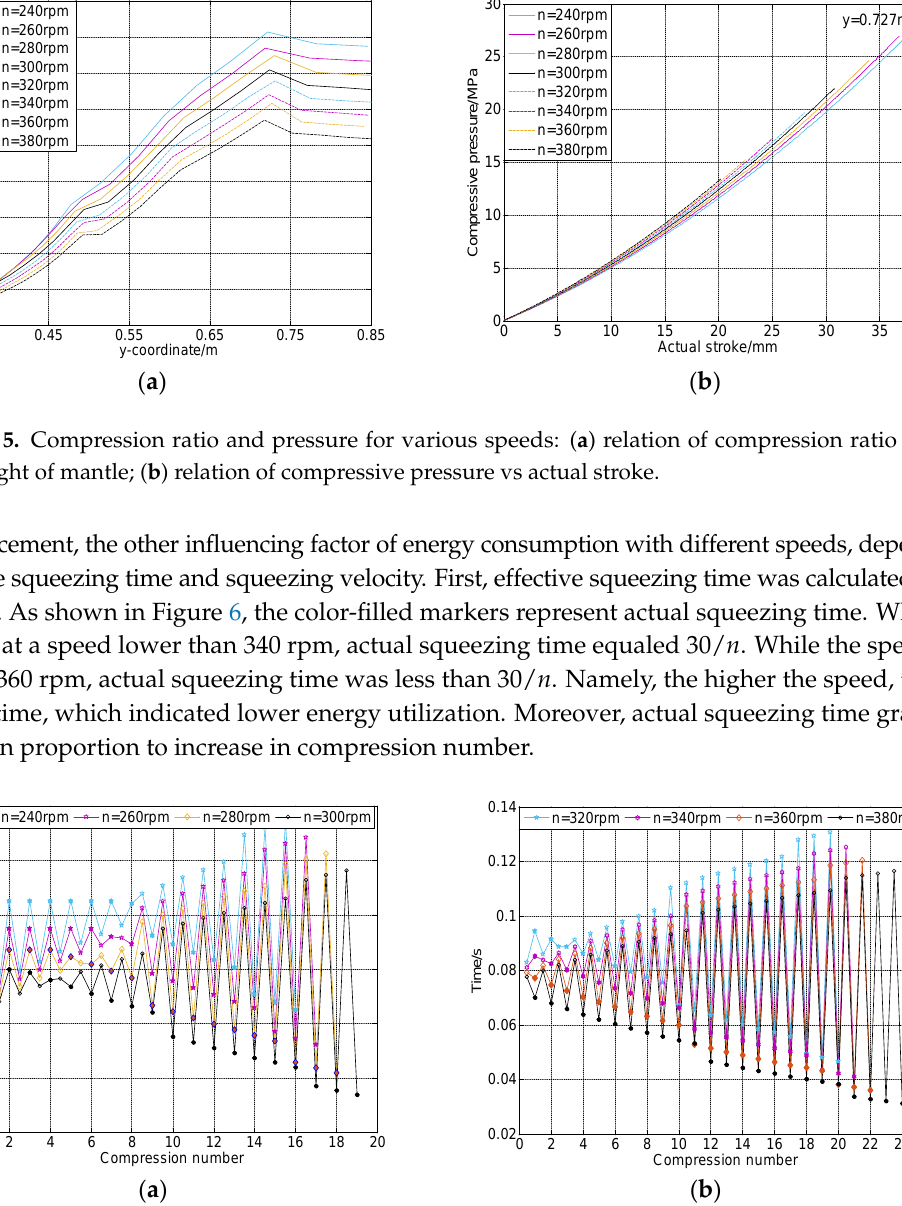
Figure 6. The influence of speed on squeezing time: ( a ) relation of compression number vs. squeezing time with speed ranging from 240 rpm to 300 rpm; ( b ) relation of compression number vs. squeezing time with speed ranging from 320 rpm to 380 rpm.